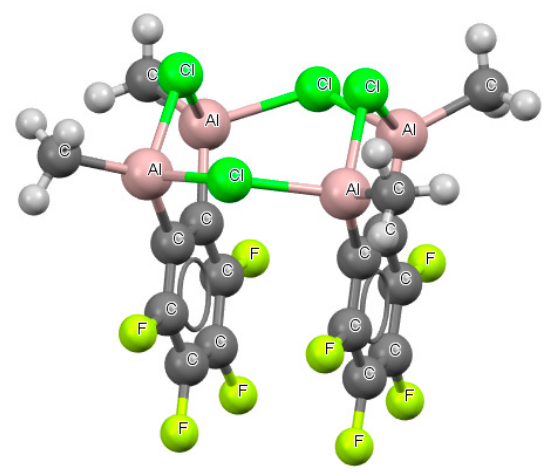
Figure 8. The fragment of the crystal structure of tetrakis( μ 2 -chloro)-bis (m2-3,4,5,6- tetrafluorobenzene)-tetra-methyl-tetraaluminium, (refcode